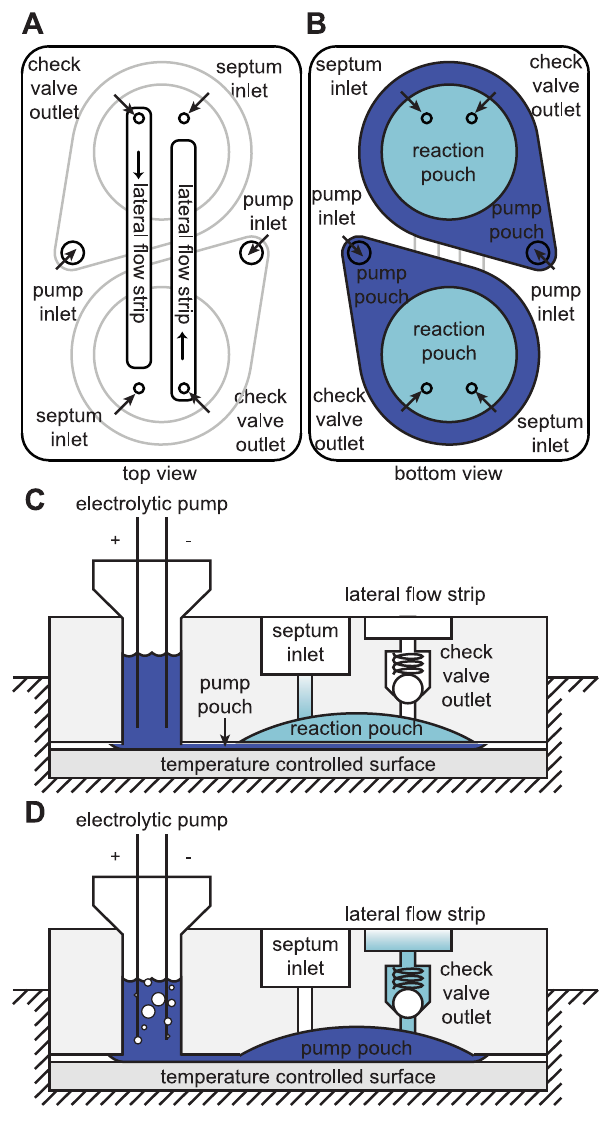
Figure 1. Cartridge concept. (a) Cartridge viewed from the top, showing access ports to the reaction and pump pouches on the underside of the cartridge (indicated in gray outline), and the position of lateral flow strips in anti-parallel orientation. (b) Cartridge viewed from the bottom, showing reaction pouches with overlaid pump pouches. (c) and (d) Side view of the cartridge on the heater (not to scale), illustrating the operating principle. (c) Master-mix is injected through the septum inlet into the reaction pouch, and targeted DNA sequences are isothermally amplified on top of the temperature- controlled heater surface. (d) Applying current to the electrolytic pump pushes fluid into the pump pouch. The pump pouch expands, thereby compressing the reaction pouch against the dome-shaped recess in the cartridge, forcing fluid out of the reaction pouch through the one-way check valve and into the lateral flow strip pouch.